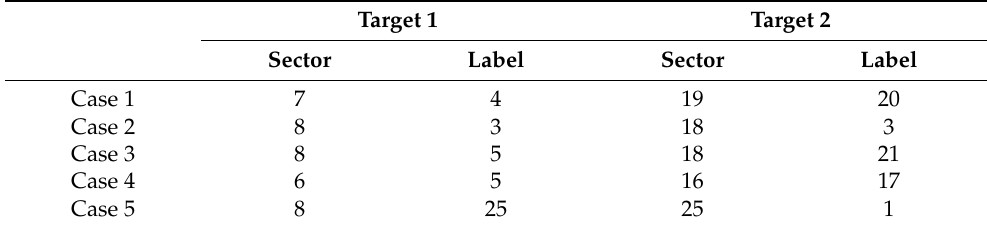
Table 6. Setting up Sectors and Labels for Targets .